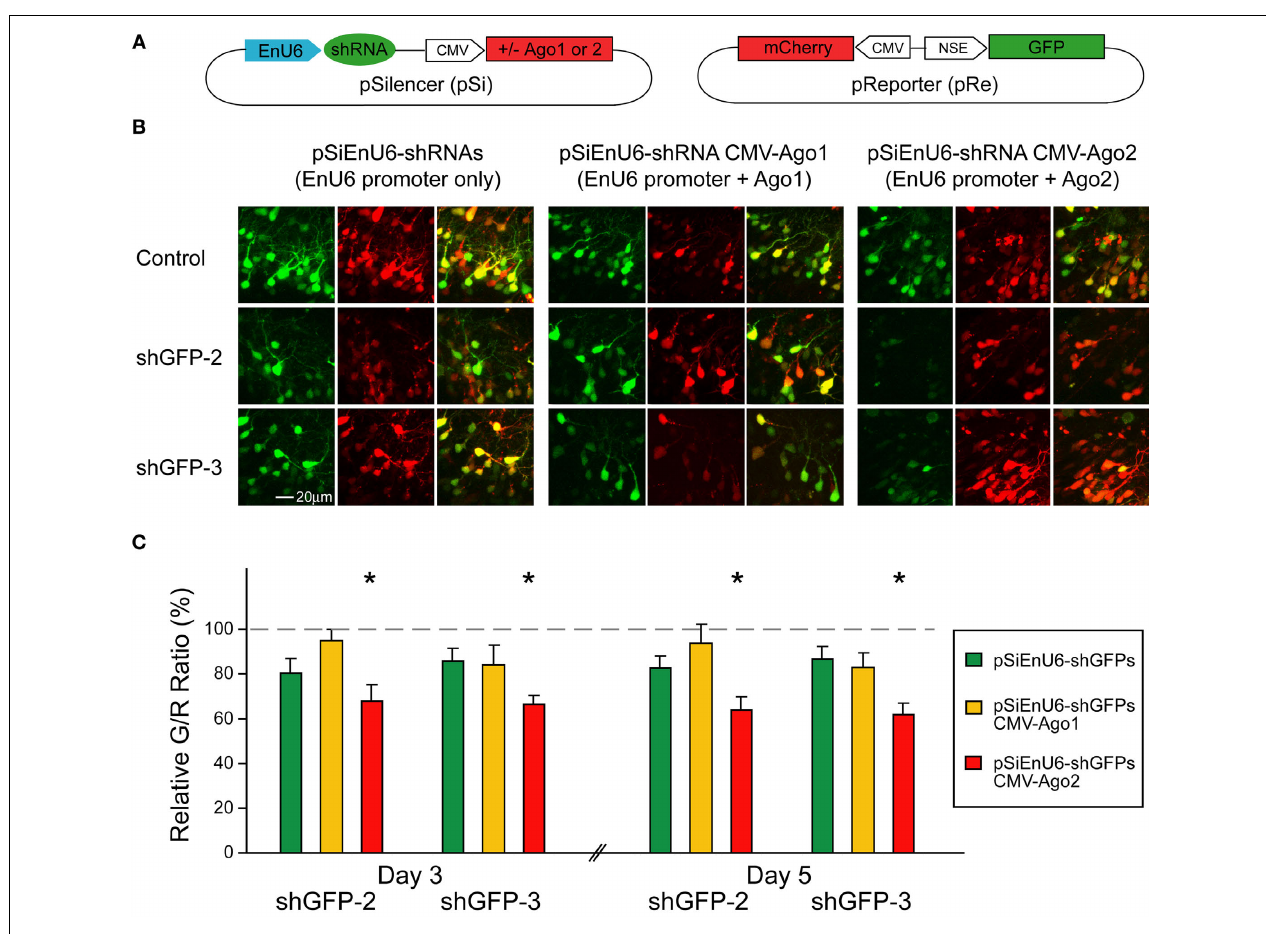
FIGURE 4 | Ago2 expression enhances RNAi in neurons of living Xenopus tadpoles. Neurons, transfected with pSi and pRe constructs, were imaged after 3 or 5 days to evaluate GFP knockdown by G/R fl uorescence intensity ratio. (A) Diagram of the pSi (left) containing EnU6-shGFPs with or without Ago protein co-expression, and the pRe (right) for simultaneous GFP and mCherry expression. (B) Representative images from CNS neurons 3 days after transfection of the pSi constructs as indicated. (C) G/R ratios measured